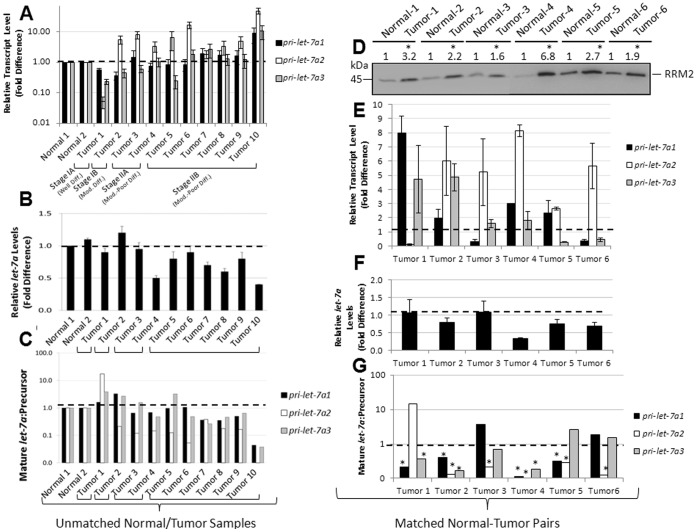
Defective processing of let-7a precursors and RRM2 overexpression in resected human PDAC tissues.
A and B, Relative expression of primary let-7a transcripts (A) and mature let-7a (B) in 2 normal pancreatic tissues and 10 PDAC samples representing various tumor stages. C, Ratios of mature to precursor let-7a transcripts calculated from data points in A and B. D, Western blotting analysis of RRM2 (45 kDa) in total lysates (50 µg) of 6 matched normal-PDAC pairs. Ratios of RRM2 band intensities in PDACs compared to matched normal tissues indicated (top). Asterisk indicates significantly higher RRM2 expression in PDAC tissues (p<0.05) compared with matched normal tissues. E and F, Relative expression of primary let-7a transcripts (E) and mature let-7a (F) in matched normal-PDAC pairs. G, Ratios of mature to precursor let-7a transcripts calculated from data points in E and F. Asterisk indicates significantly lower mature to precursor let-7a ratio in PDAC tissues (p<0.05) compared with matched normal tissues.